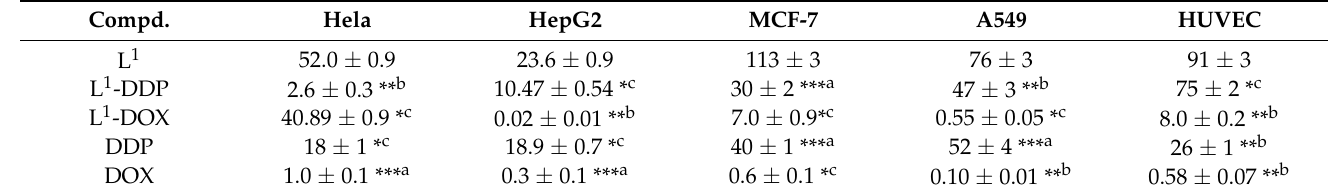
Table 4. Antiproliferative activities of L 1 , DDP, DOX, L 1 -DDP, and L 1 -DOX (IC 50 ± SE*/ µ gmL − 1